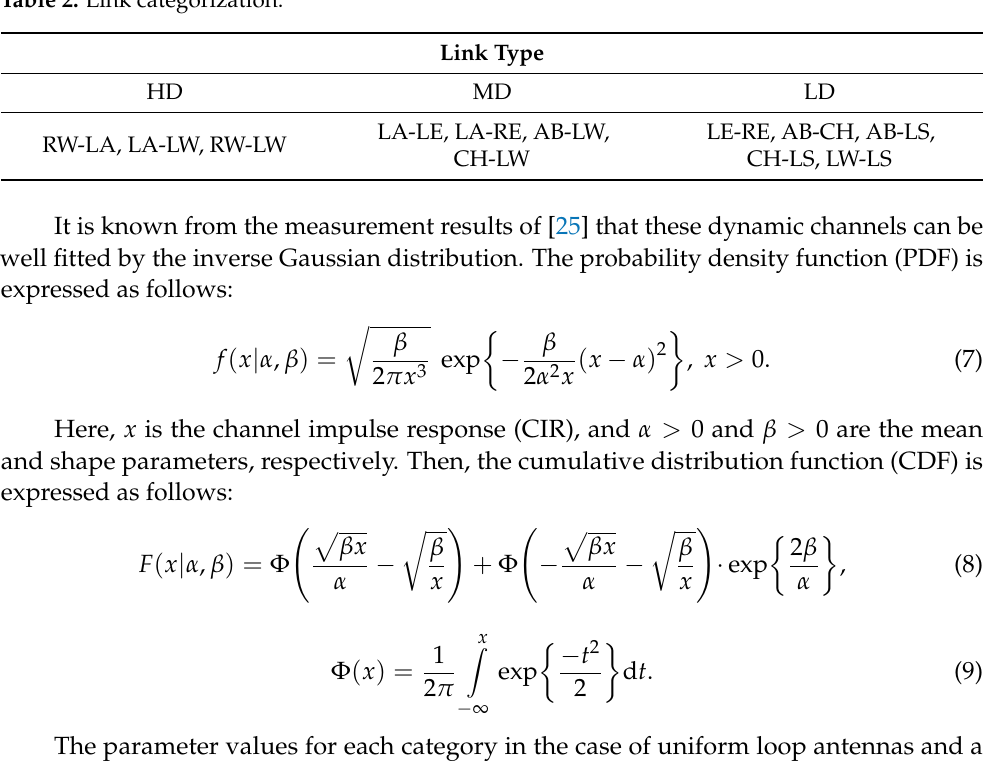
Table 2. Link categorization.